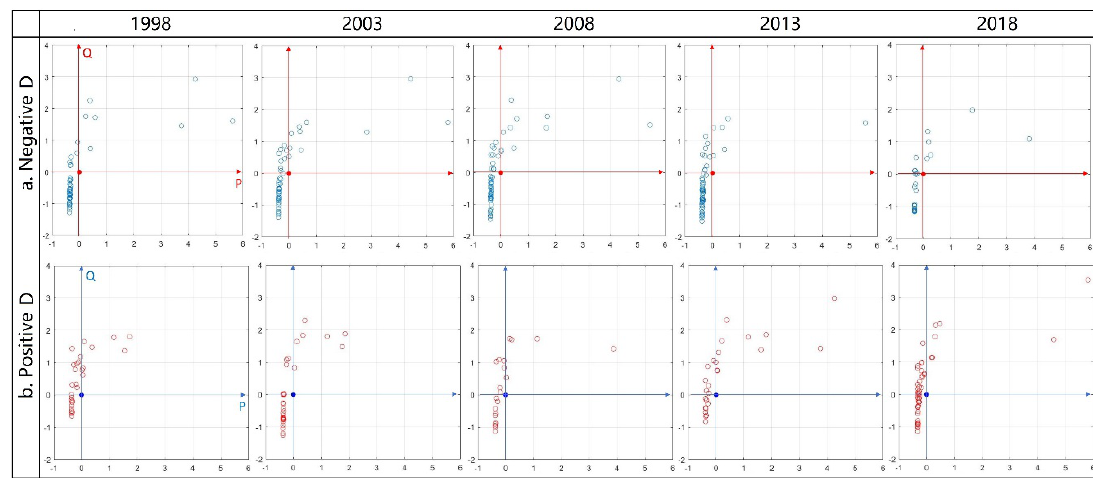
Figure 15. Multidimensional assessment results projected on D plane at the county level.